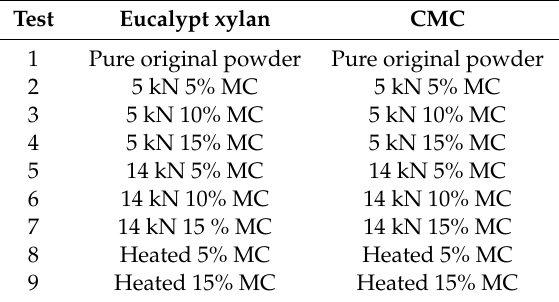
Table 2. Tests matrix for eucalypt xylan pellets, carboxymethyl cellulose (CMC) pellets and powder samples for spectrophotometer test at variated applied force (kN) and moisture content (MC).